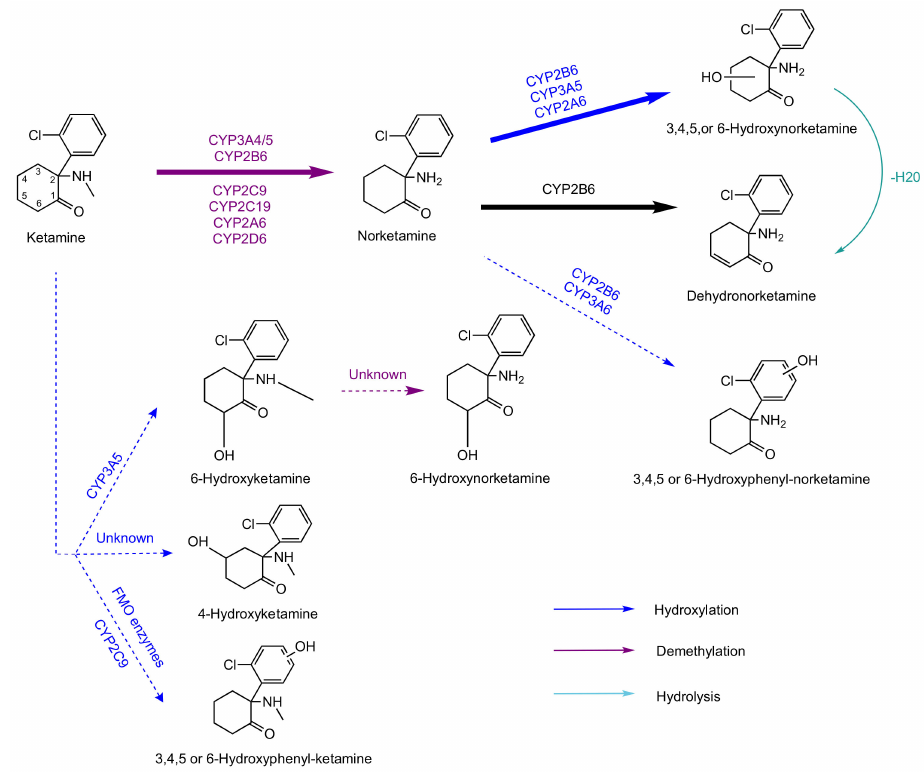
Figure 3. Overview of ketamine’s metabolism [26,45,46,51–53]; bold arrows indicate the major path- way and dotted arrows indicate minor metabolic pathways; FMO: flavin-containing